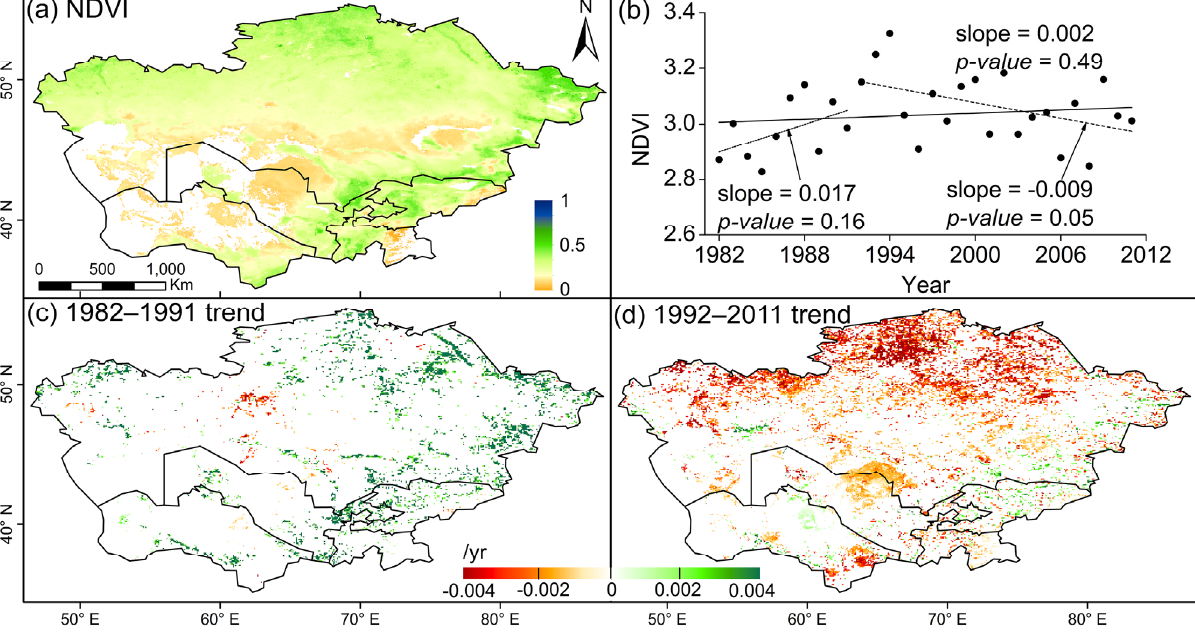
Figure 4. ( a ) Map of the annual NDVI and ( b ) spatially averaged NDVI trend for 1982–2011. ( c , d ) represent the maps of the annual NDVI linear trends for 1982–1991 and 1992–2011, respectively. The areas with significant trend correspond to a p -value < 0.05.